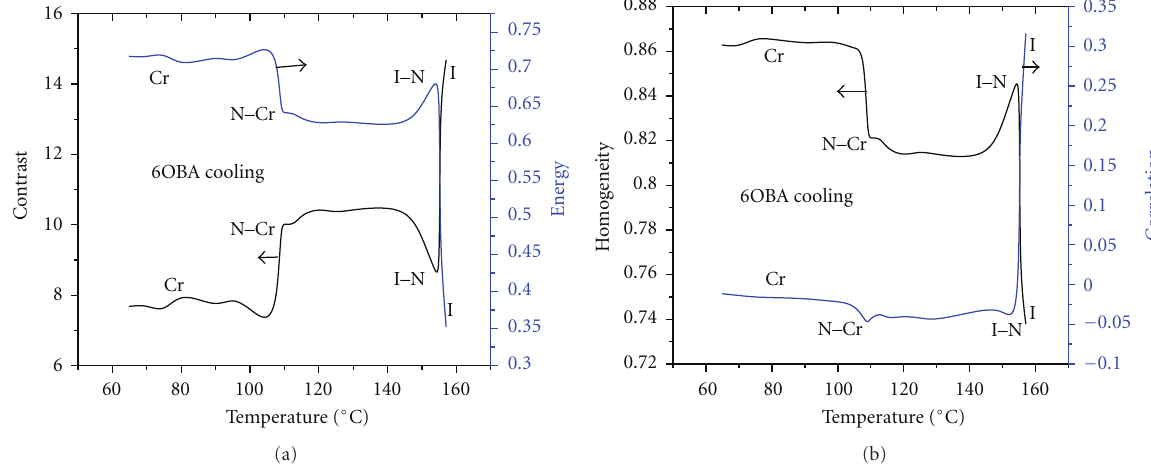
Figure 6: Computed parameters from the textures of 6OBA as a function of temperature where the phase transitions are indicated. (a) Contrast and energy; (b) homogeneity and